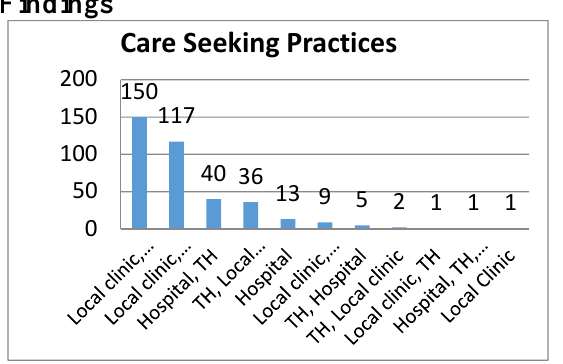
Table 2. Change in Use of Service Providers